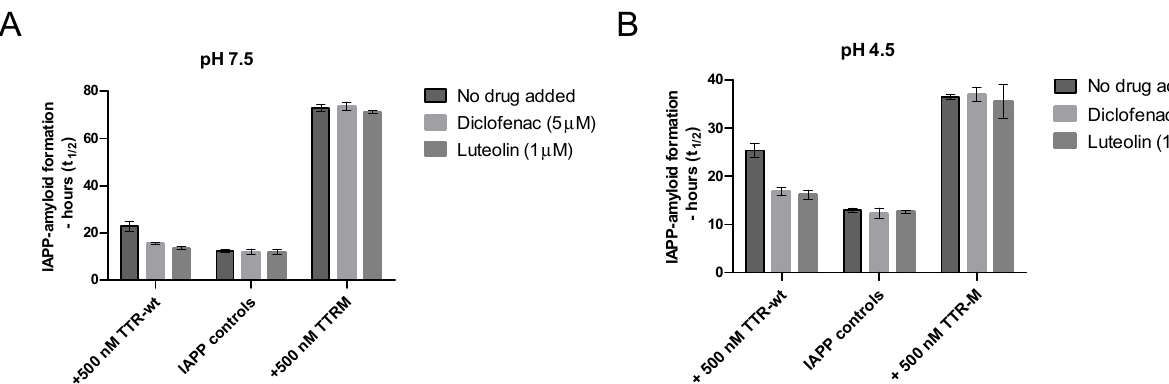
Figure 5. Inhibition of IAPP amyloid formation by TTR as a function of TTR-stabilizing ligands at neutral and low pH. Amyloid formation of IAPP incubated in PBS (pH 7.5) or 25 mM citric acid pH 4.5, 150 mM NaCl, was probed against 500 nM of TTR-wt as well as TTR-M in the presence versus absence of the tetramer stabilizing drugs luteolin (1 μ M) and diclofenac (5 μ M). Figure ( A ) illustrates the result at neutral pH at 5 μ M of IAPP. Figure ( B ) illustrates the results at pH 4.5 (note that 10 μ M of IAPP was used in the setup at low pH). A significant reduction of the inhibiting propensity of the TTR stabilizing drugs was observed regarding the tetrameric TTR-wt, p -value <0.005 (unpaired t -test), both at neutral and low pH. TTR-M, which is unable to bind to the ligands, was unaffected at neutral and low pH.